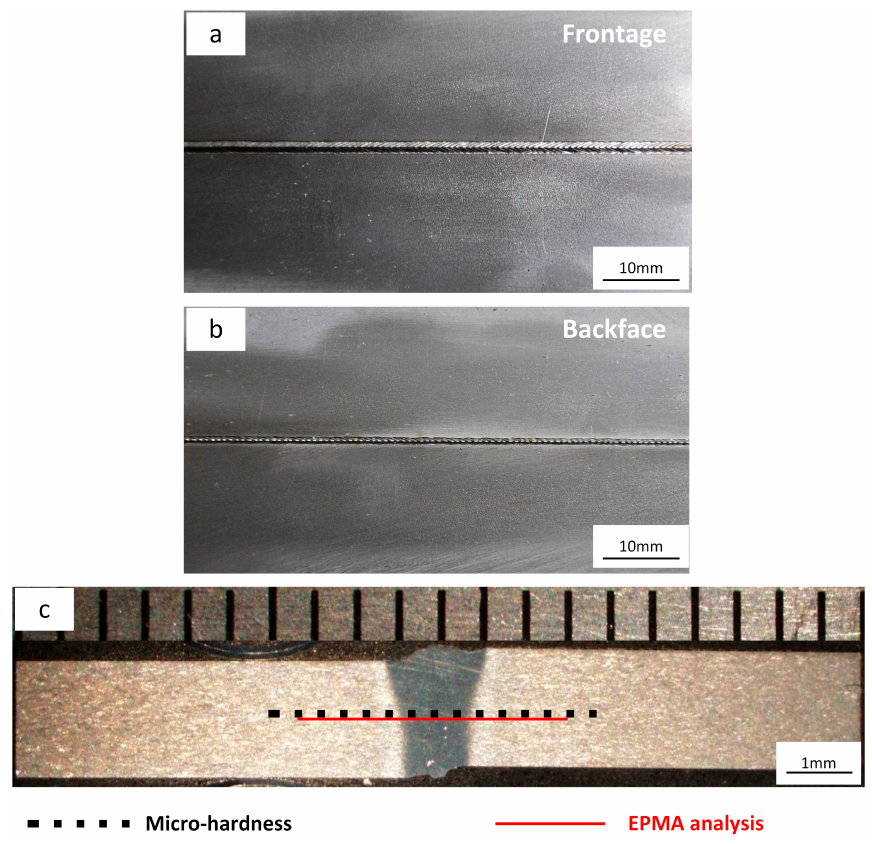
Figure 2. Appearance of BTi-6431S laser welding joint: ( a ) face of the welded joint; ( b ) root of the welded joint; ( c ) macro view of the surface of weld with indication of the location of the microhardness and EPMA testing.